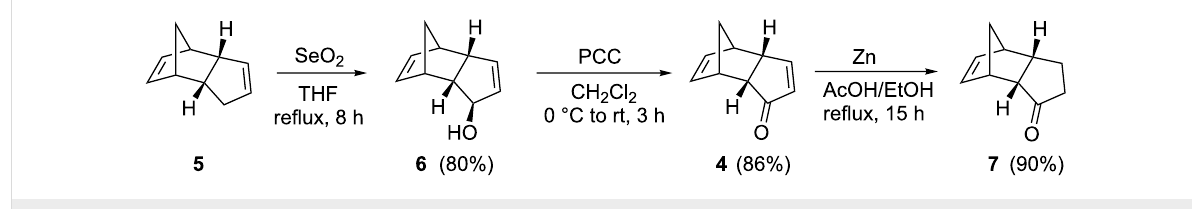
Scheme 1: Synthesis of tricyclic ketone 4